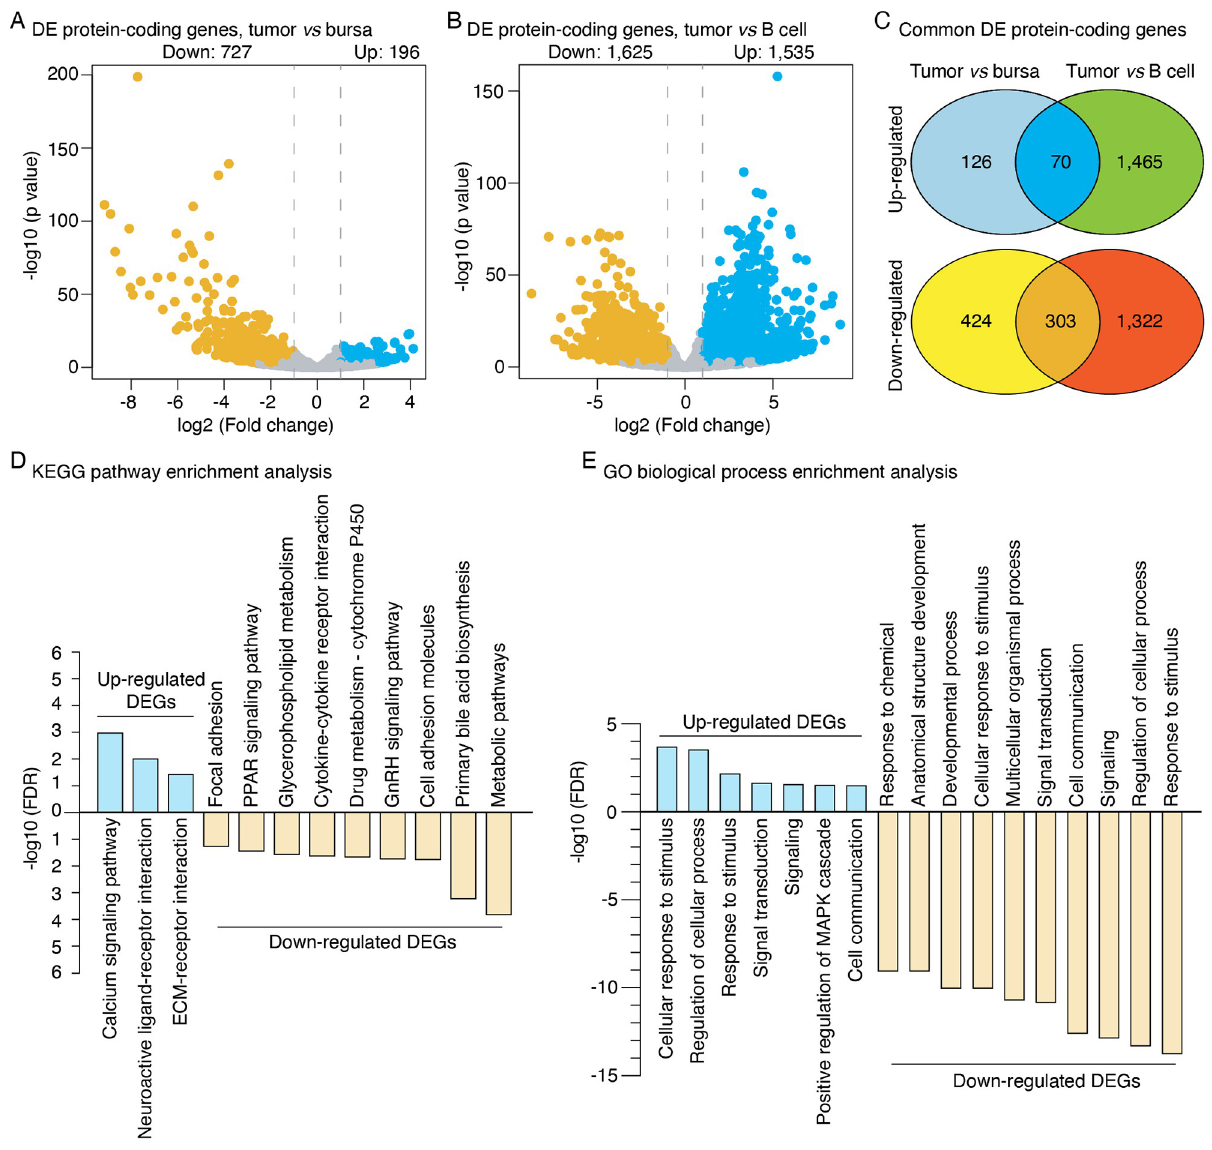
Fig 3. Differentially expressed protein-coding genes and function enrichment analysis. (A) Volcano plot showing the numbers of significantly up- and down-regulated protein-coding genes in tumor samples as compared to normal bursal and (B) splenic B cell controls. (C) Venn diagram showing the number of common significantly up- and down-regulated protein-coding genes identified by both comparison pairs of tumor samples vs normal bursal controls and tumor samples vs splenic B cell controls. (D) Significantly enriched KEGG pathways and (E) GO terms of biological process for significant up- and down-regulated PCGs. The top 10 most significantly enriched GO terms of biological processes for down-regulated protein-coding genes were